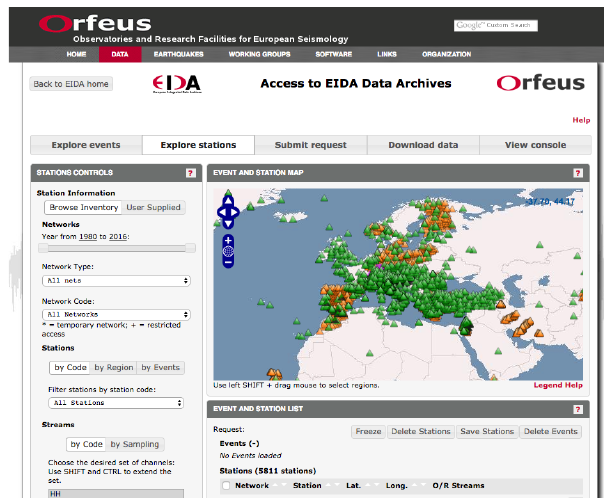
Figure 4. EIDA access portal to the seismic